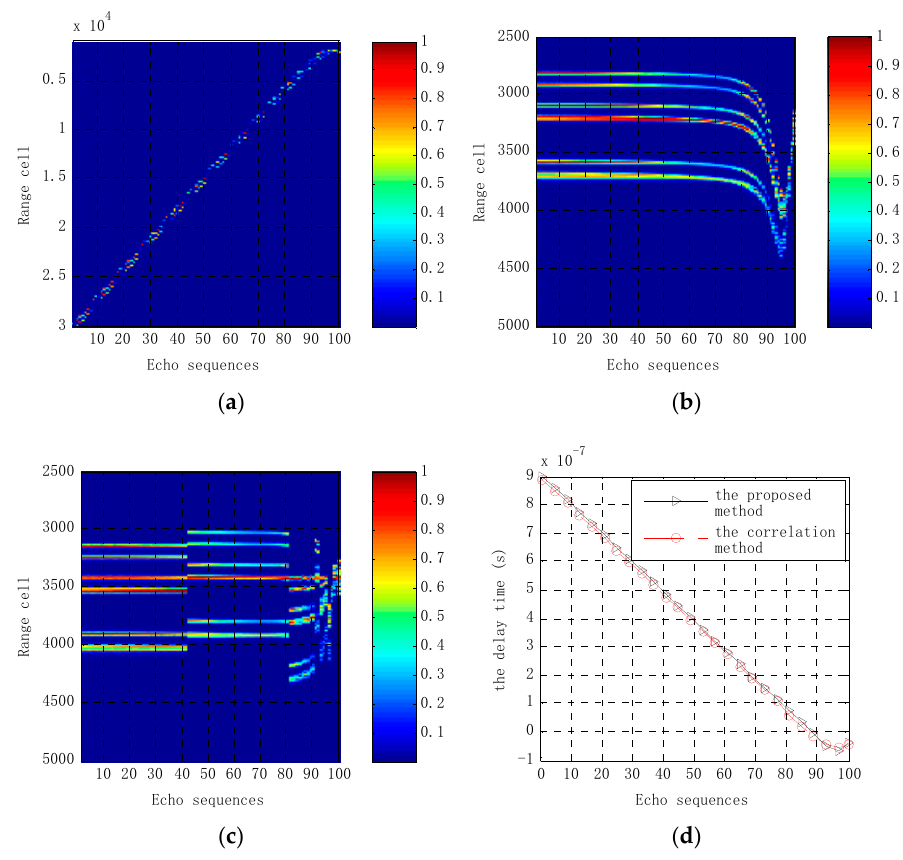
Figure 8. Results of echo sequences received by the first receiving antenna before and after translation compensation. ( a ) Before and after translation compensation; ( b ) After translation compensation using the proposed method in this paper; ( c ) After translation compensation using the correlation method; ( d ) The delay time used in translation compensation.